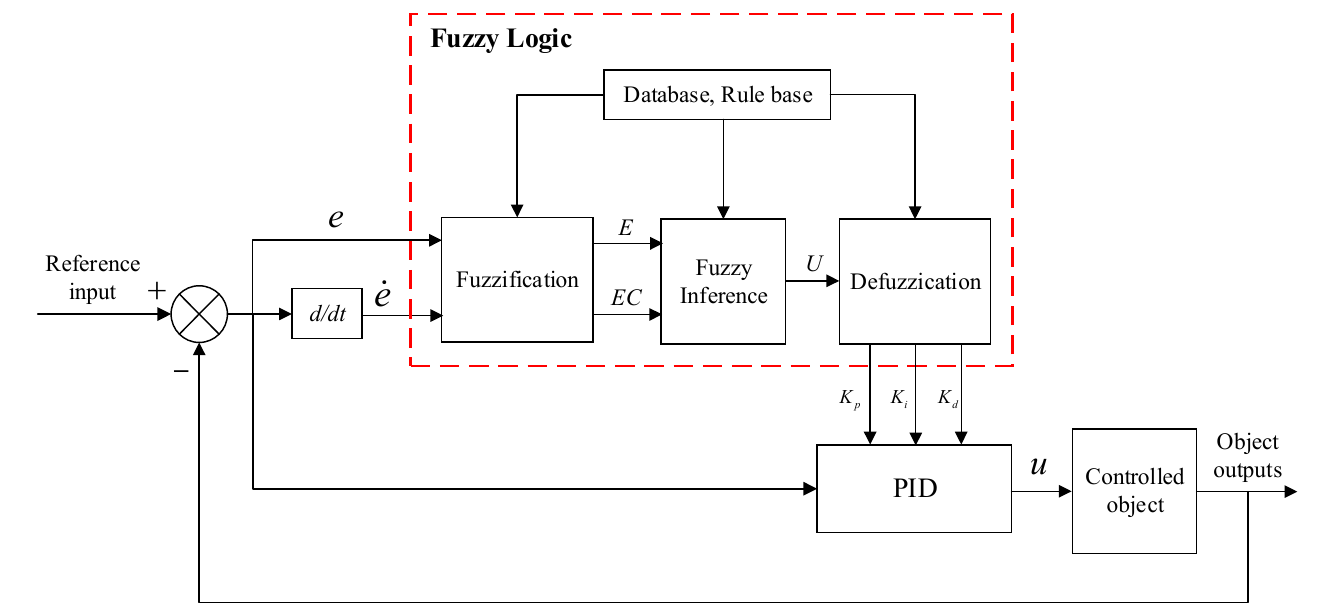
Figure 12. Fuzzy PID control system.